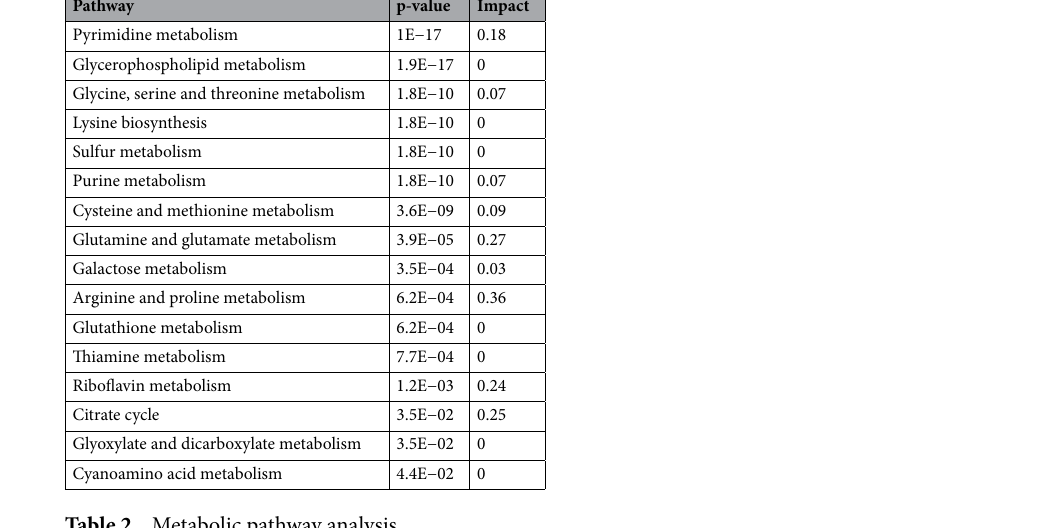
Table 2. Metabolic pathway